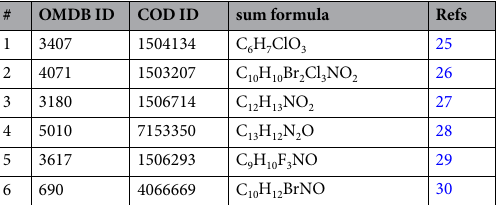
Table 1. Data-mined organic Dirac materials with the space group 19. The first four materials show crossings in the valence band, the latter two have crossings in the conduction band. References to the papers where the synthesis of the materials was reported are given in the last